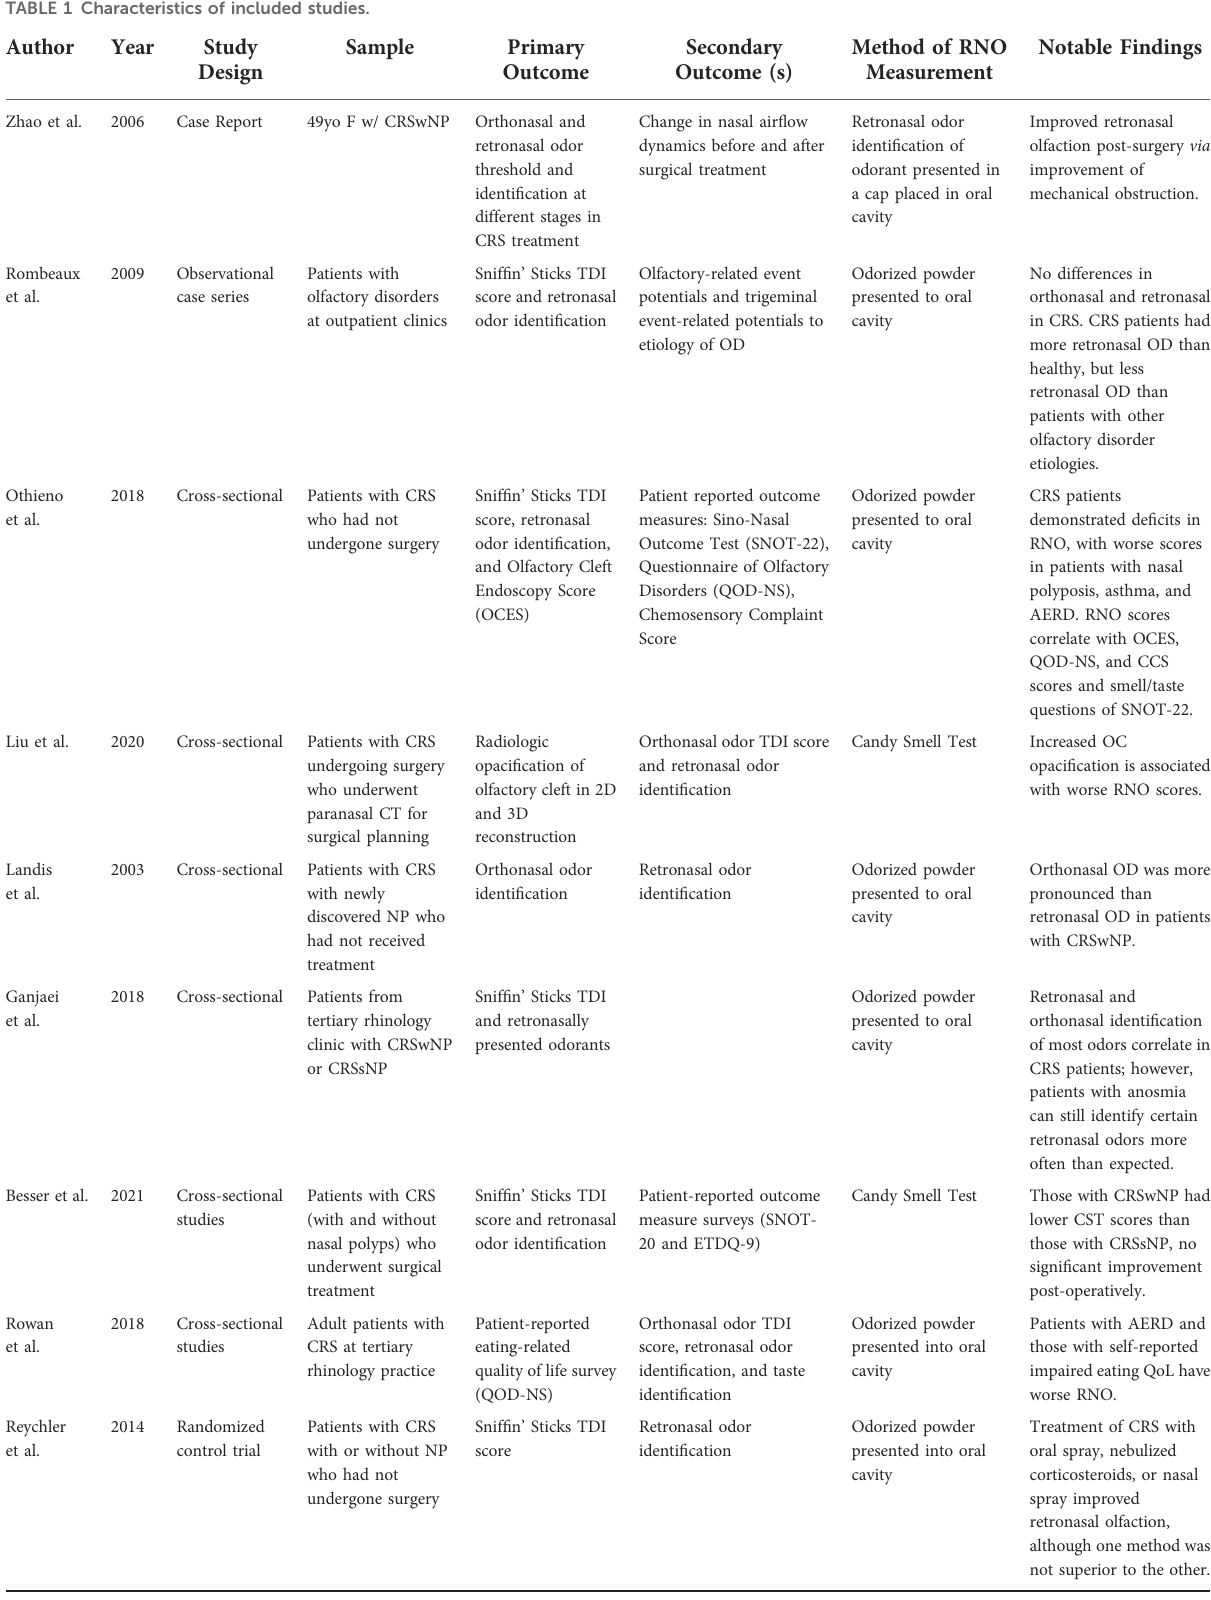
TABLE 1 Characteristics of included